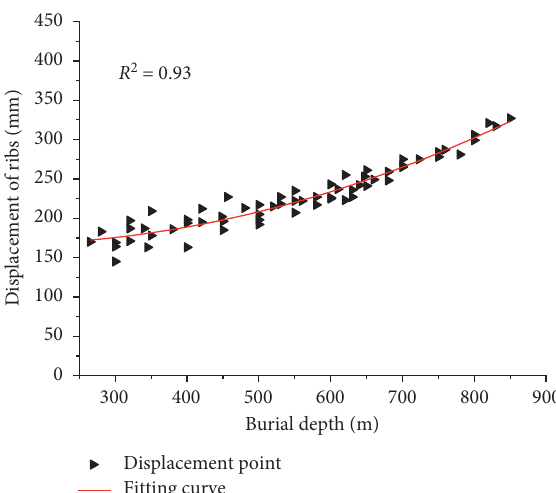
Figure 26: 20m away from the working